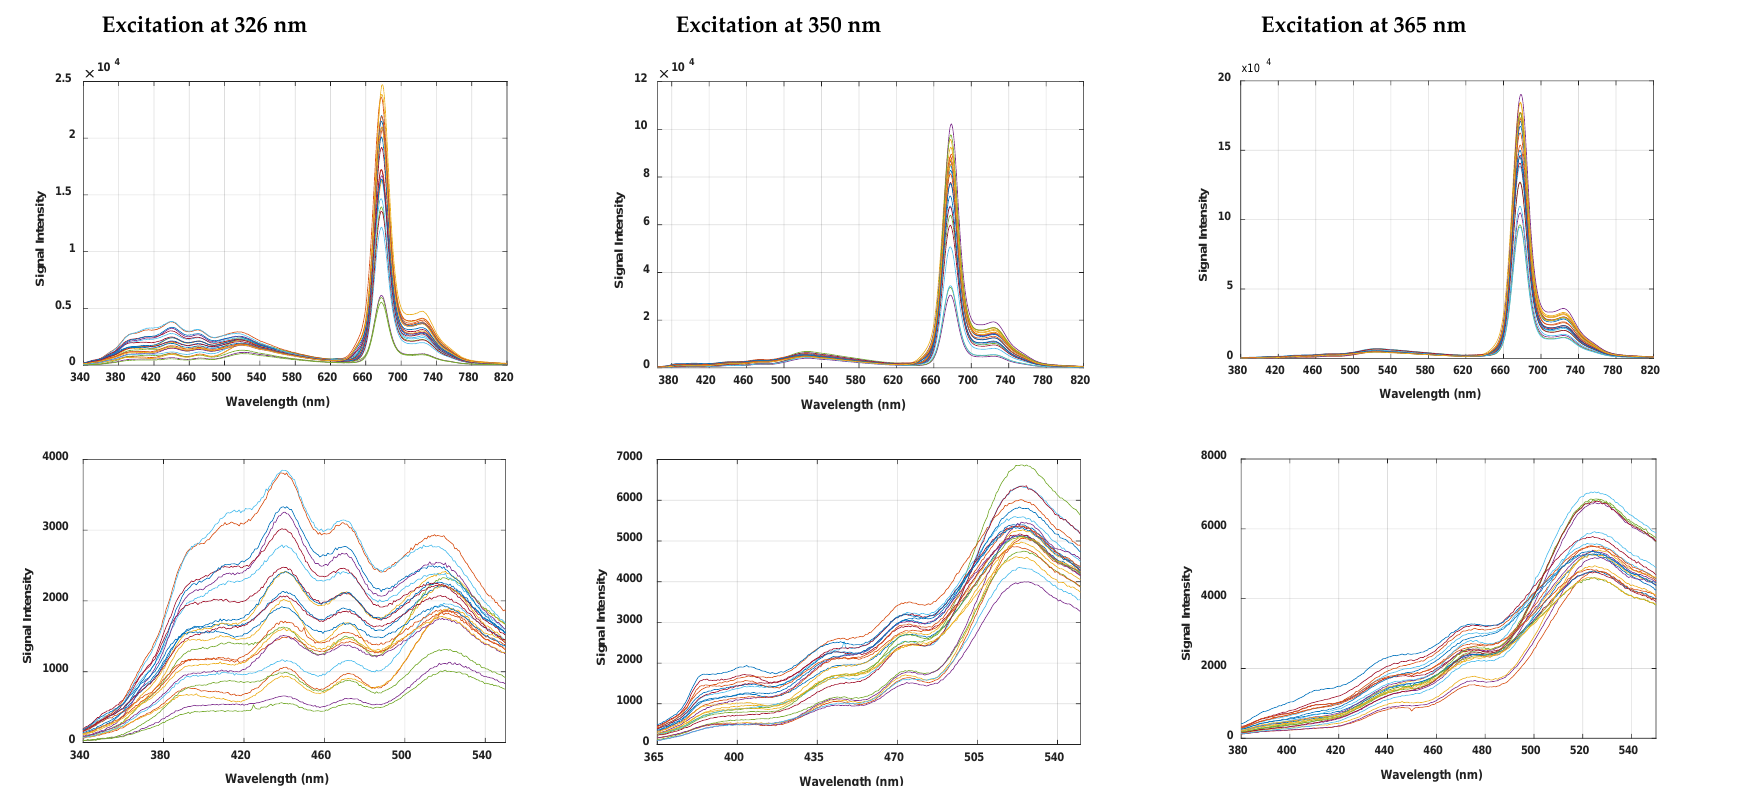
Figure 4. Fluorescence emission spectra. Upper row: fluorescence emission spectra ( N = 24 samples) obtained at excitation wavelengths centered at 326, 350 and 365 nm. Bottom row: detailed emission between 340 nm and 550 nm.